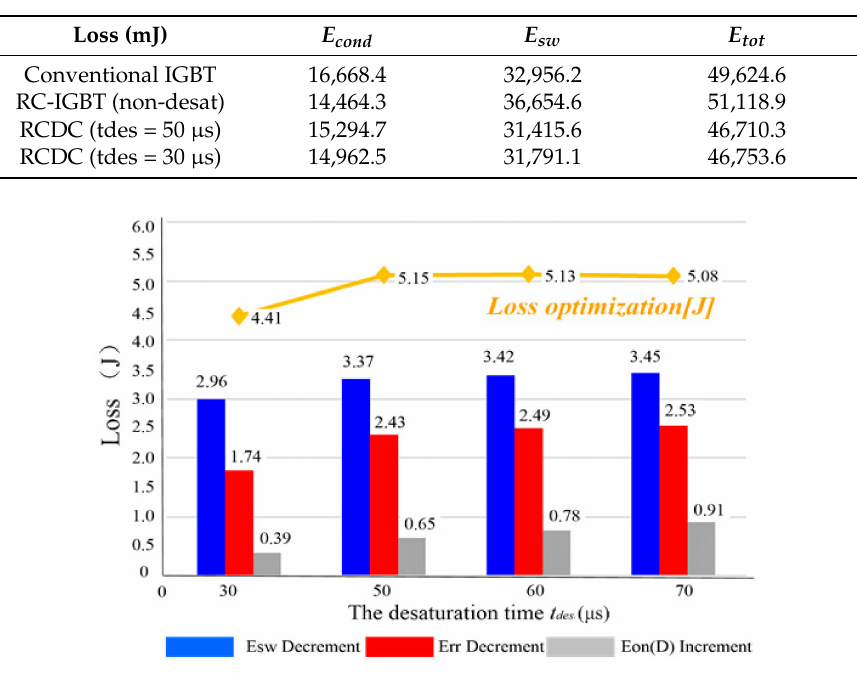
Figure 16. Loss comparison between Conv-IGBT and RC-IGBT applied to a 1.4 MW PWM